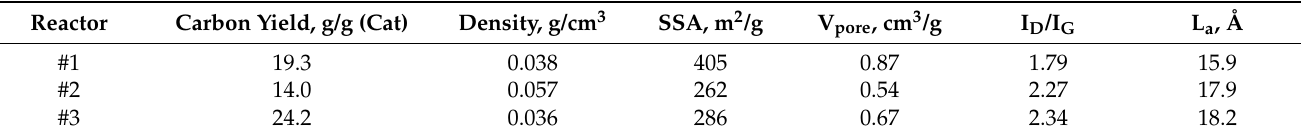
Figure 3. Photographs of the carbon products accumulated using various reactors: ( a ) reactor #1; ( b ) reactor #2; ( c ) reactor #3. Table 1. Characteristics of the carbon products accumulated over Ni-Pd catalyst at 600 ◦ C for 2